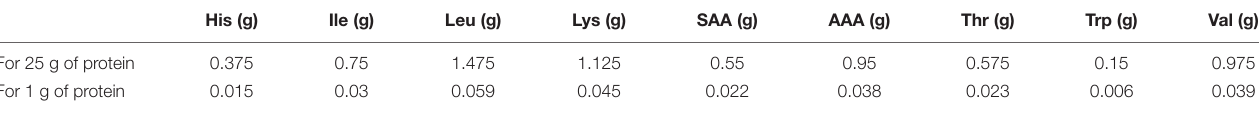
TABLE 2 | Fixed nutritional constraints according to the IAA scoring pattern for adults [Adapted from FAO